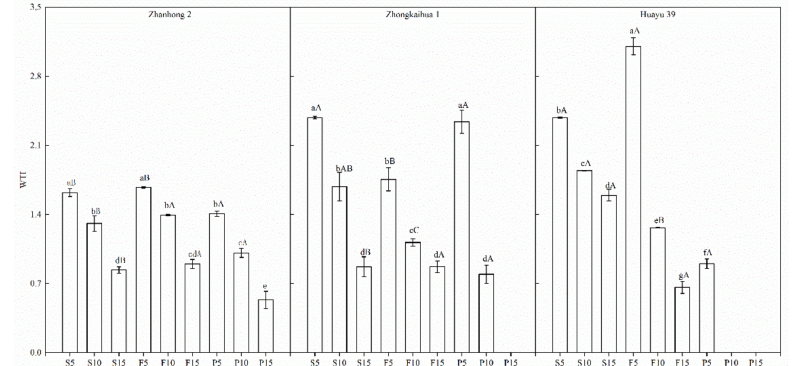
Figure 2. E ff ects of waterlogging stress on the waterlogging-stress tolerance index (WTI) in